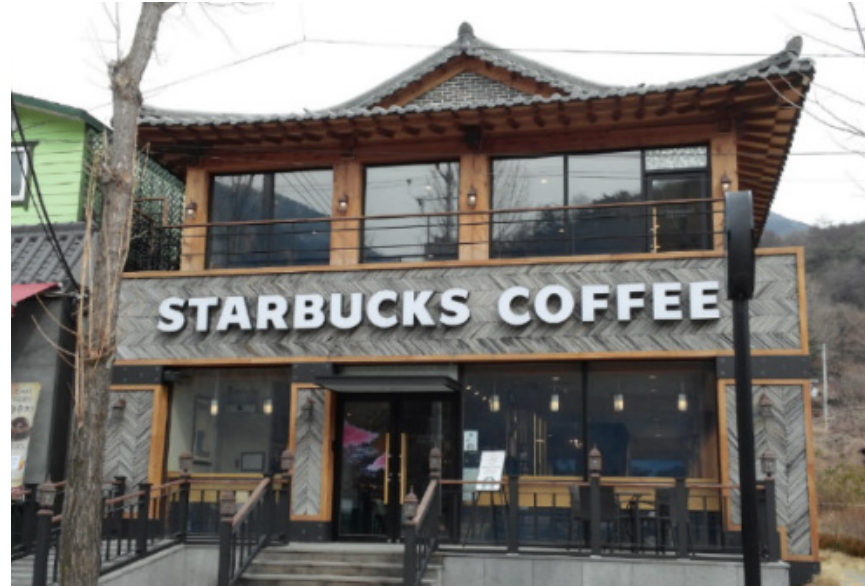
Figure 20. Starbucks in MungyeongSaejae.